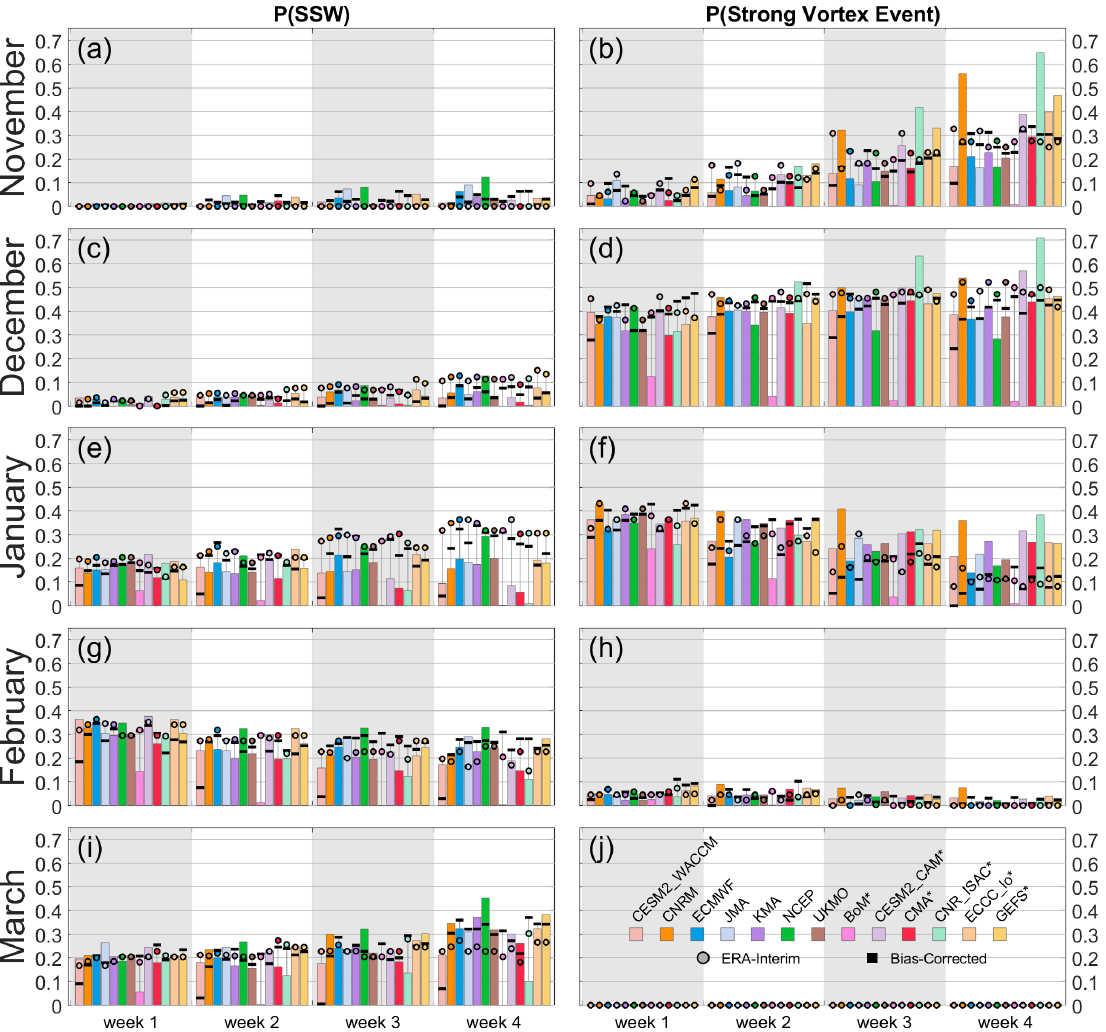
Figure 6. Probability of boreal (a, c, e, g, i) sudden stratospheric warmings and (b, d, f, h, j) strong vortex events, shown individually for composites of initializations within each month (rows) and weekly lead time (horizontal axis, alternating grey–white background shading within panels). For each model, the solid bars show the raw estimates, while the bold horizontal black lines indicate the probability determined after bias correction. The colored circles indicate the probabilities computed using ERA-I and subsampled to match the same dates from each individual set of model